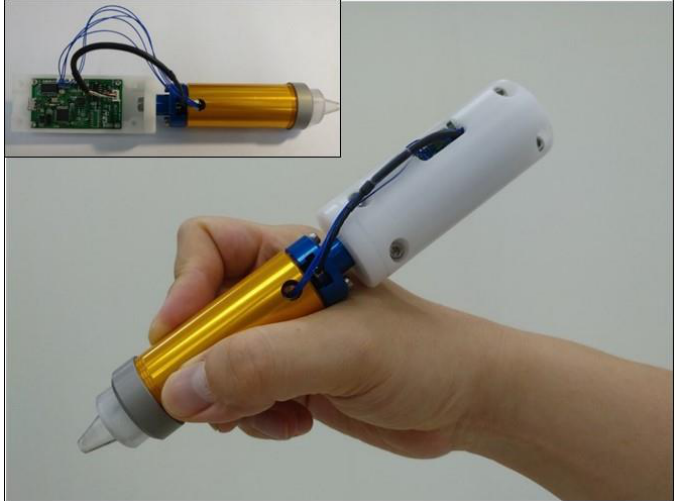
Figure 2. Fabricated pen-type multimodal device.